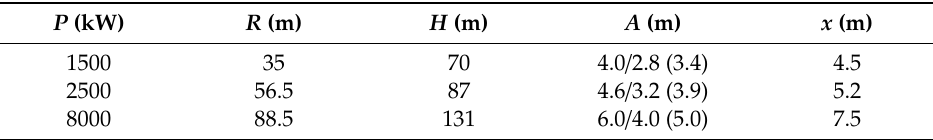
Table 1. Parameter values of 3 different typical wind turbines.